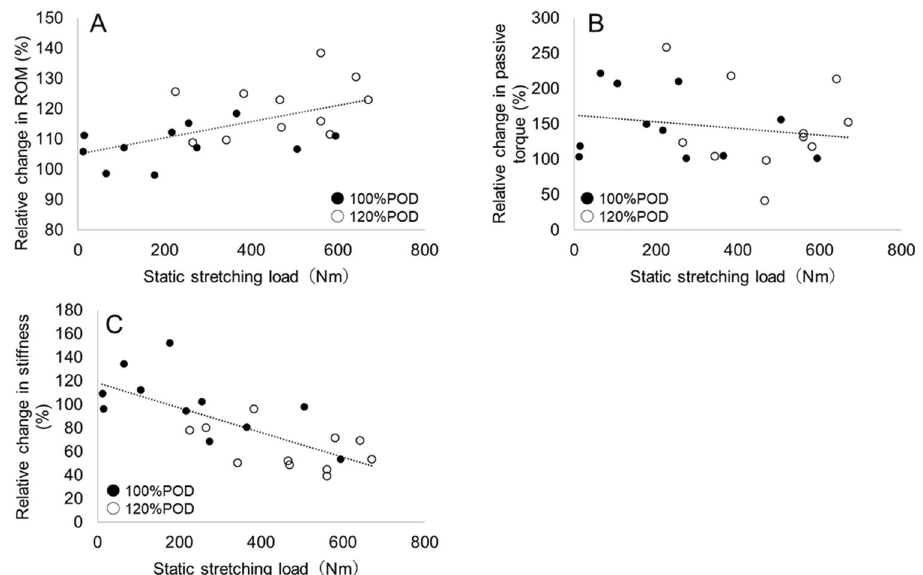
Figure 3. Correlation between static stretching load and relative changes in knee extension ROM ( A ), passive torque at end ROM ( B ), and muscle–tendon unit stiffness ( C ). ROM: range of